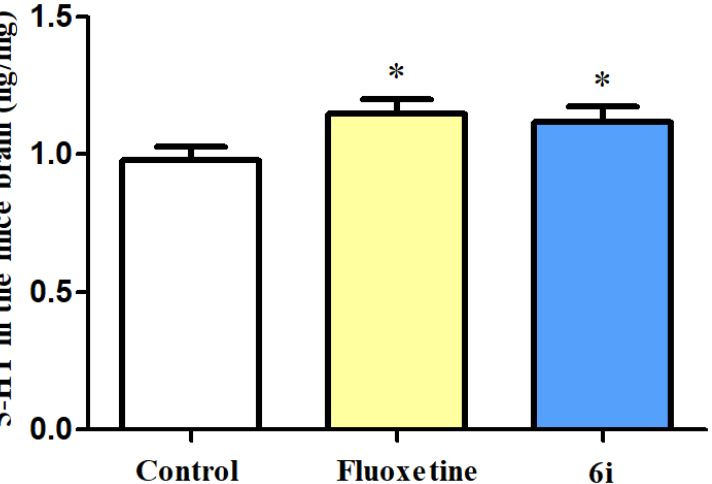
Figure 5. Effect of compounds 6i and Fluoxetine on brain 5-HT level in mice. Compounds 6i and Fluoxetine were analyzed by the concentration of 5-HT in the mice brain 1 h after oral administration. Values represent the mean ± SEM ( n = 8). * Significant compared to control (0.01 < p < 0.05).